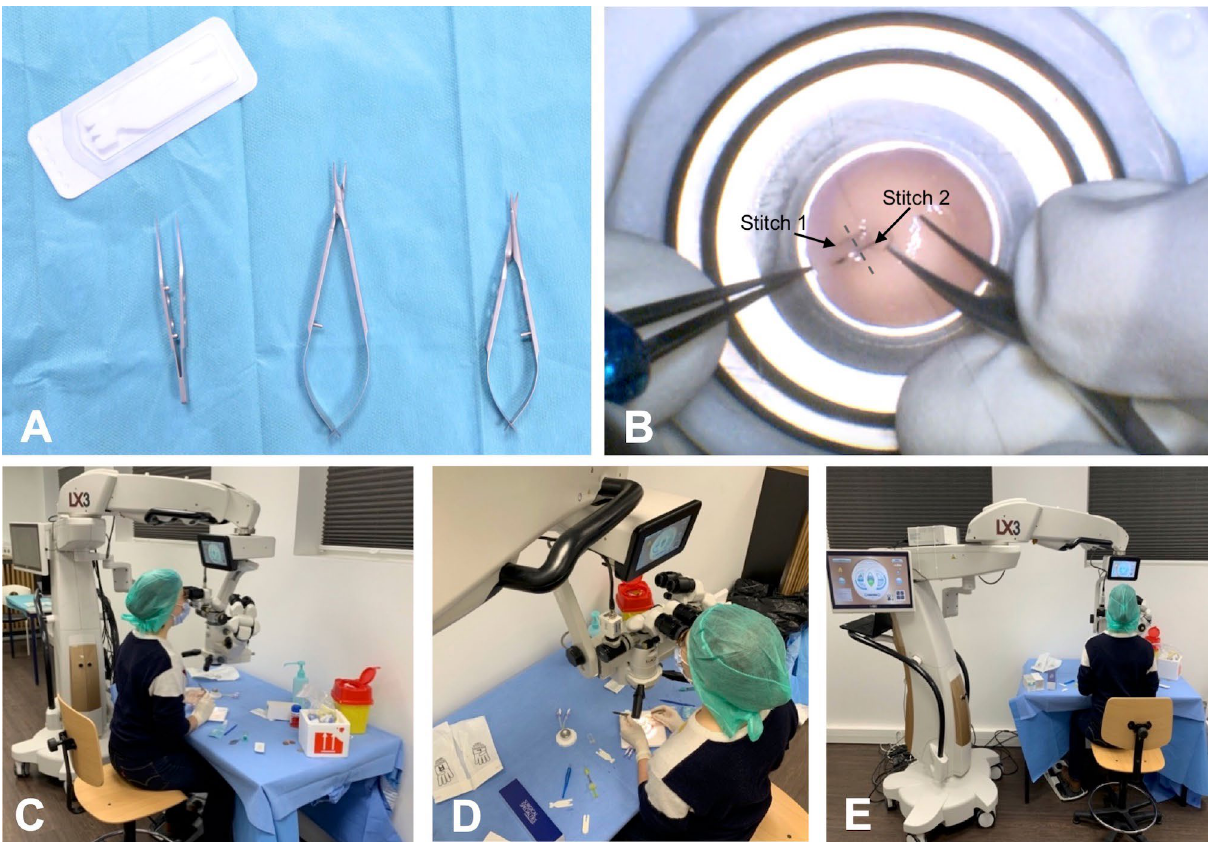
Figure 4. Surgical training instruments and recording. ( A ) Instruments used during training sessions: 10-0 Ethilon Nylon suture threads (Ethicon, US, LLC, top left). At the bottom of the image, from left to right: Bonn forceps (left), Barraquer needle holder (middle) and Vannas scissors (right). ( B ) Microscope camera view showing one paracentral corneal wound (grey dotted line) being closed by separated stitches. The first stitch is completed (stitch 1, black arrow), while the second stitch is in progress with the needle already introduced into the cornea (stitch 2, black arrow). ( C ) Room camera showing the participant’s arm, forearm and trunk position. ( D ) Room camera showing the participant’s hand and wrist movements. ( E ) Room camera showing participant’s head, back and leg